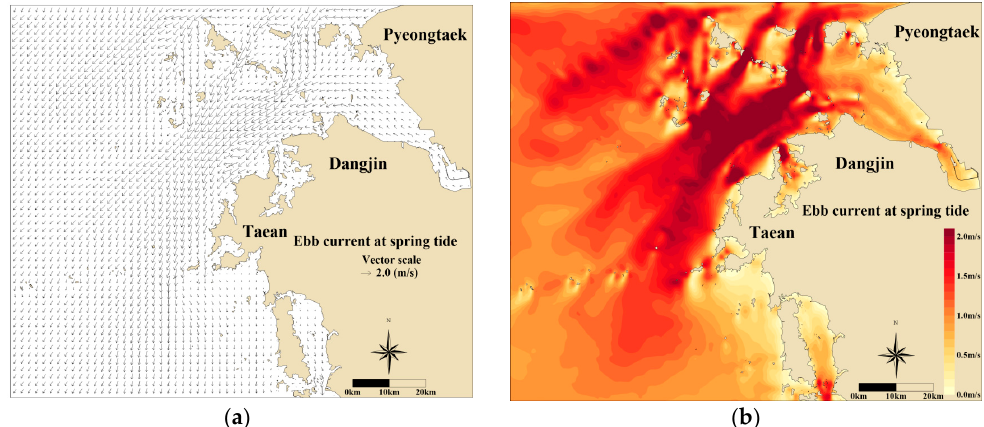
Figure 10. Flood current at spring tide in the surface layer at ( a ) temporal current velocity vector and ( b ) contour plot.